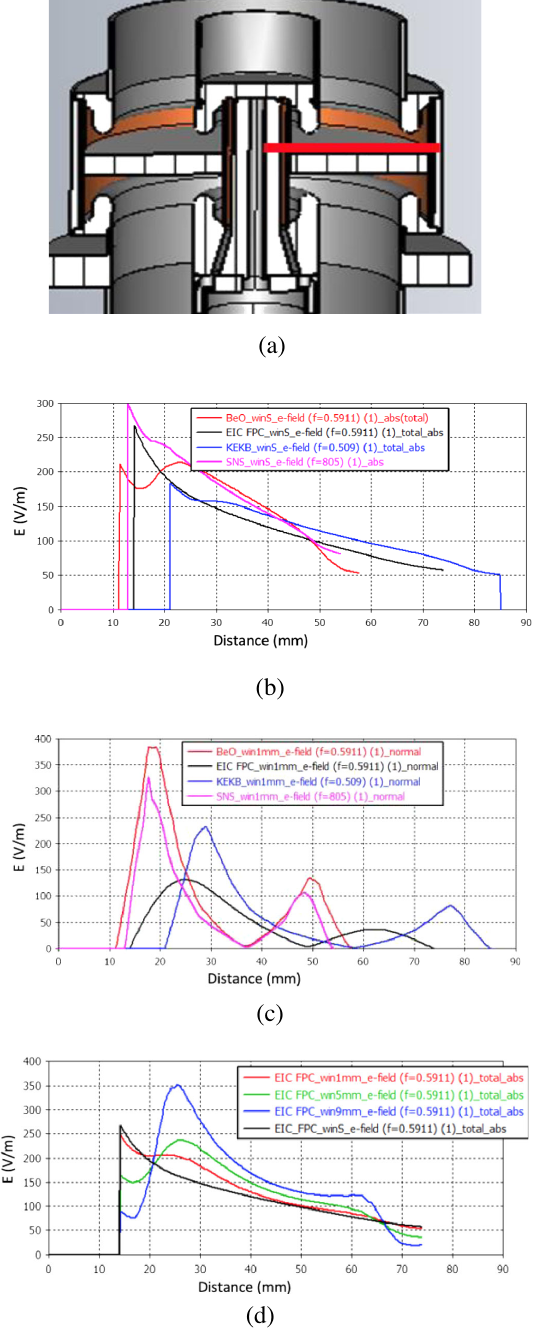
FIG. 6. Fields near the rf window. (a) Field plot along the red line (along radius direction). (b) Absolute electric field on the surface of window along radius (horizontal axis). (c) Normal component of the electric field (to window surface) offset by 1 mm from the window surface along radial path (horizontal axis). (d) Absolute field at various distances away from the window surface.